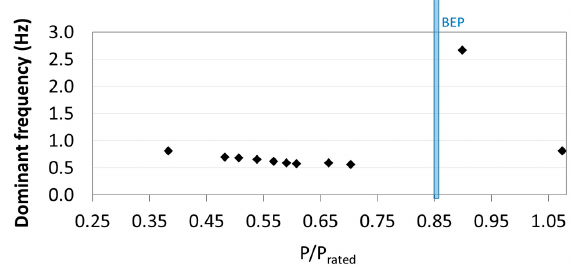
Figure 8. Dominant frequency for the whole range of operating conditions of the machine.